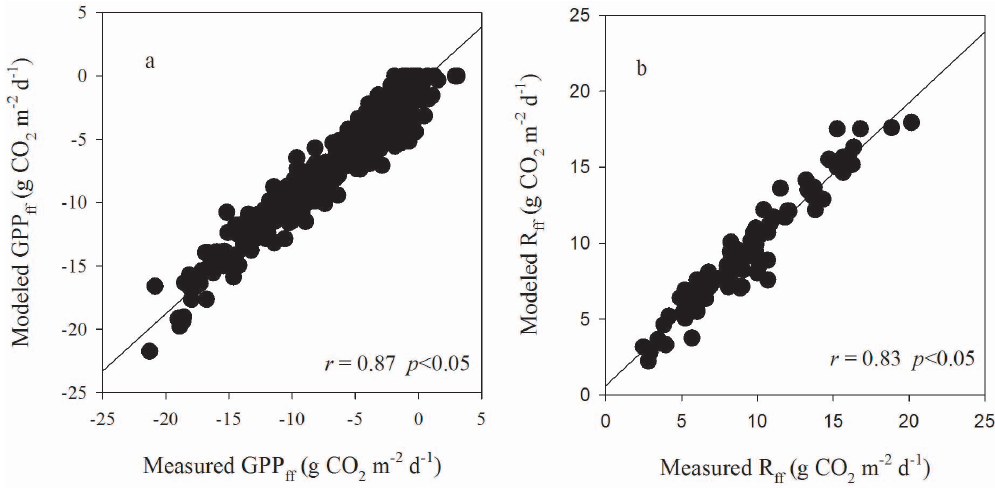
Fig. 1. Goodness of fit ( r 2 ) between (a) modeled and measured GPP ff and (b) modeled and measured R ff . The measured data used in these figures were chosen randomly and were not used for construction of models. Both 2011 and 2012 data from control and drained sites are presented. Lines represent the 1 : 1